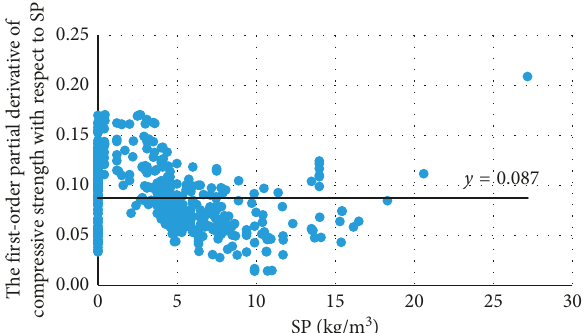
Figure 11: Performance of the 10 testing slump samples.